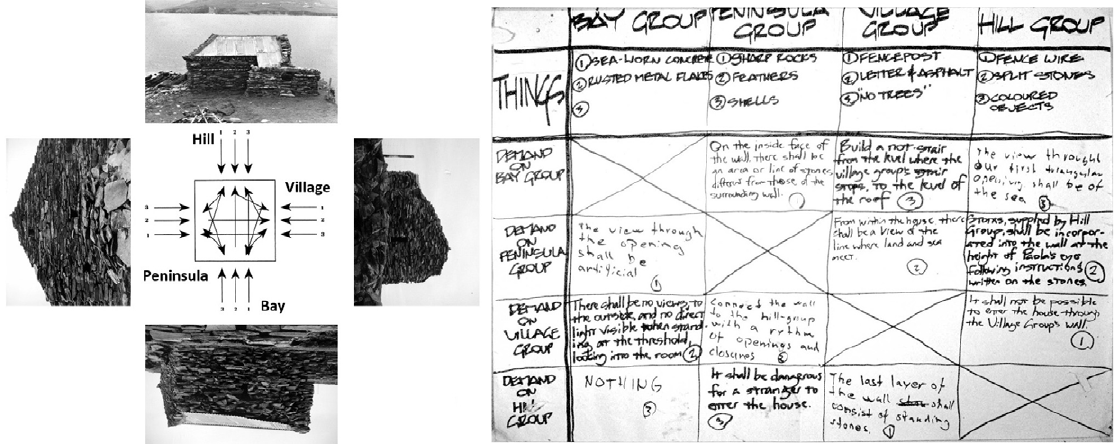
in 2015 (foreground) and guesthouse (background) finished in 2017. Source: Author. Figure 4 (pages 157, bottom): Miaoxia community kitchen. Source: